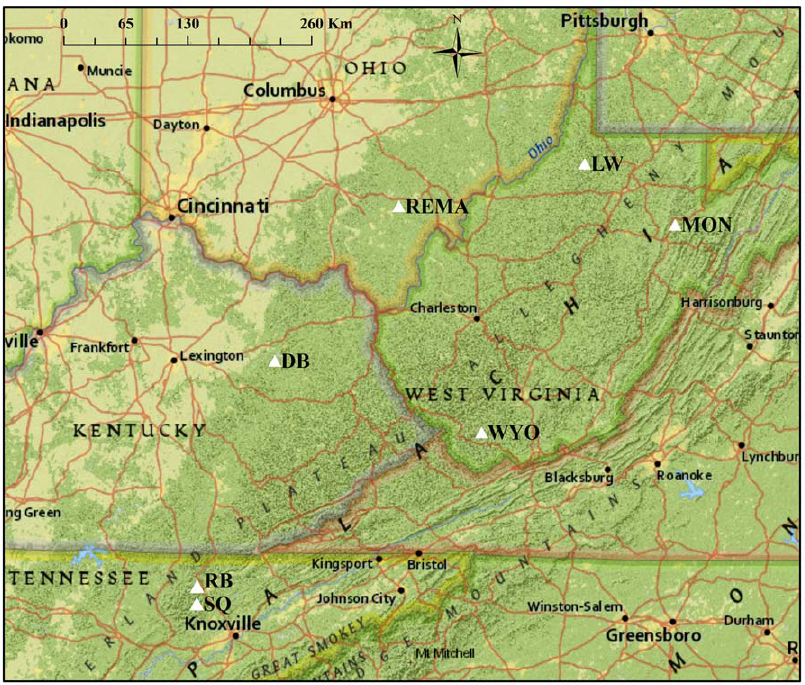
Figure 1. Map displaying locations of seven study sites in the Appalachian Mountains. All sites (white triangles) are located within the core of the cerulean warbler breeding range.